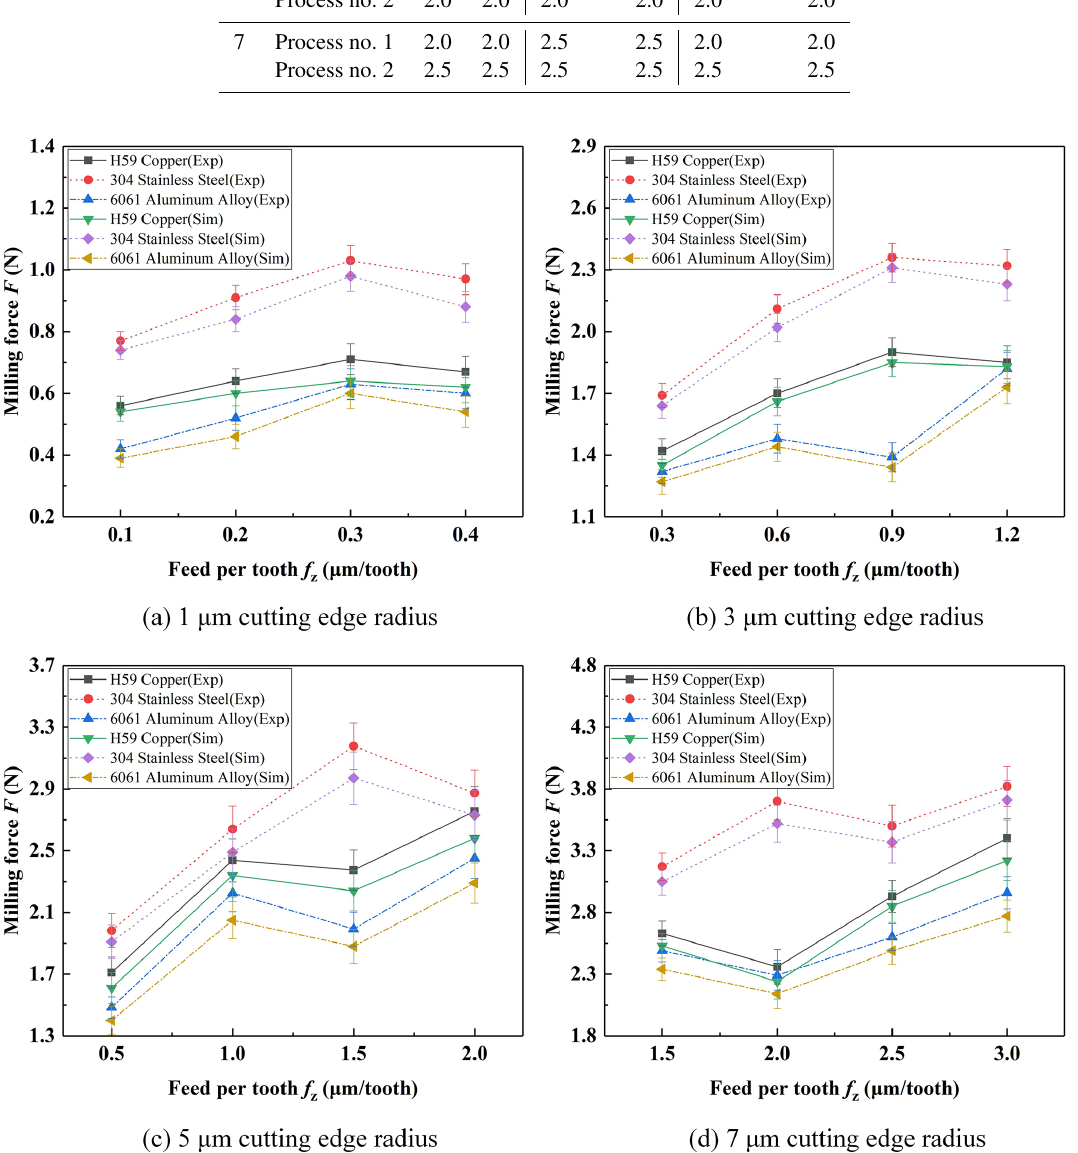
Figure 3. Milling force results of the peripheral cutting edge (process no.